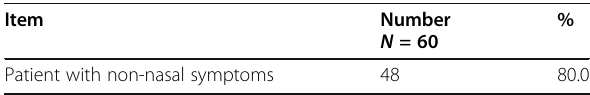
Table 8 Distribution of cases according to their non-nasal symptoms